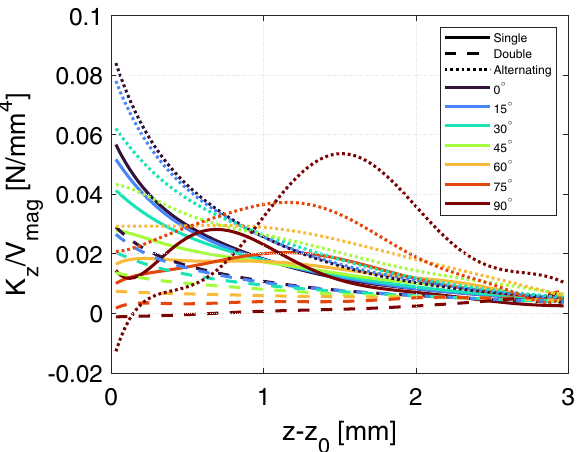
Figure 6. The volume normalized stiffness in the z -direction as function of the relative z -displacement for the different bearings considered. The stiffness is the r -direction can simply be calculated according to Eq. (2).